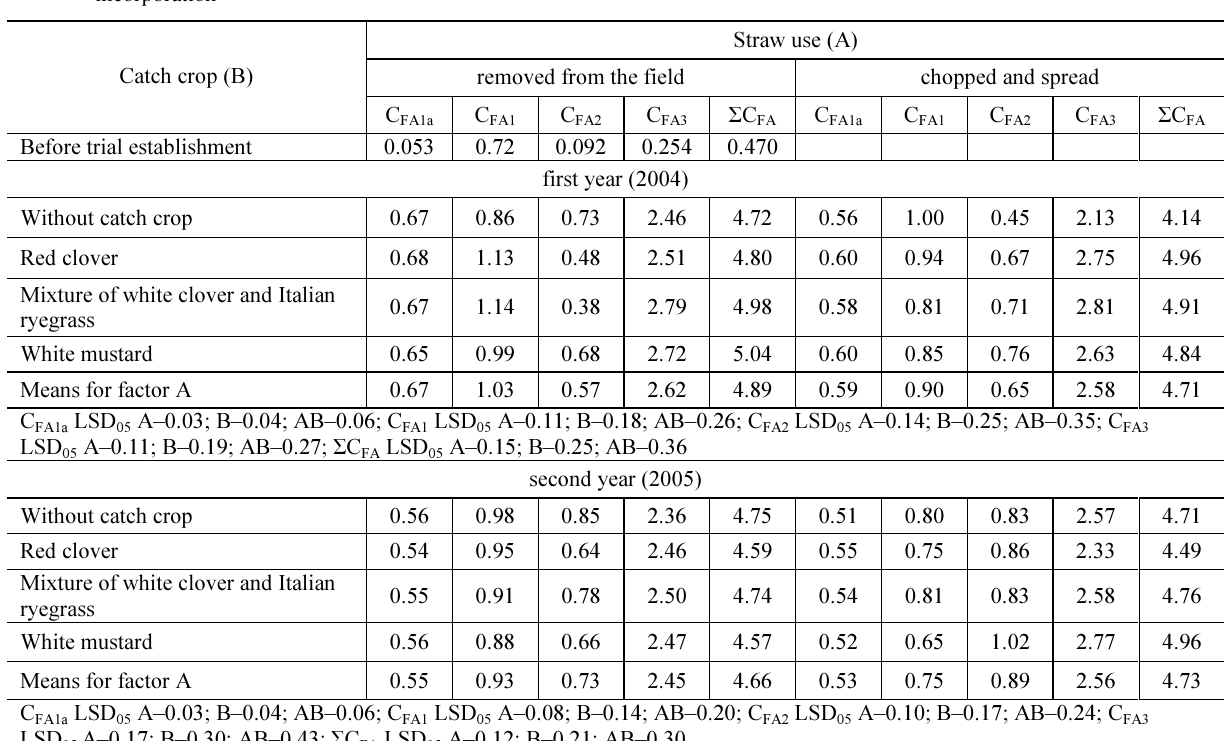
Table 3. Change of fulvic acids (C FA ) fractions (C g kg –1 of soil) in the soil (0–25 cm) after catch crop biomass and straw